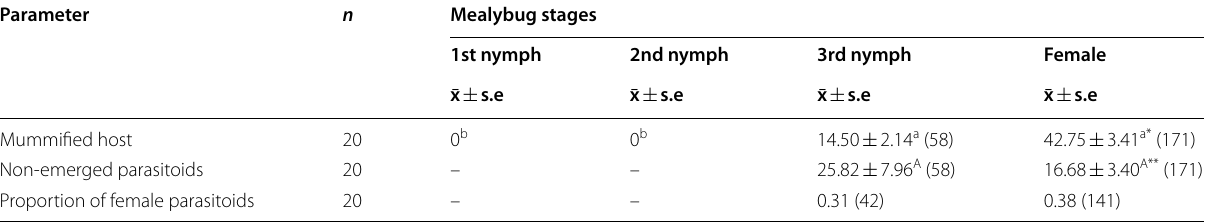
Figures under n indicate number of experimental wasps. Numbers in parentheses indicate total numbers *Means within a row followed by different lowercase letters are significantly different (Dunn–Bonferroni, P **Means within a row followed by different uppercase letters are significantly different (Mann–Whitney U test, P